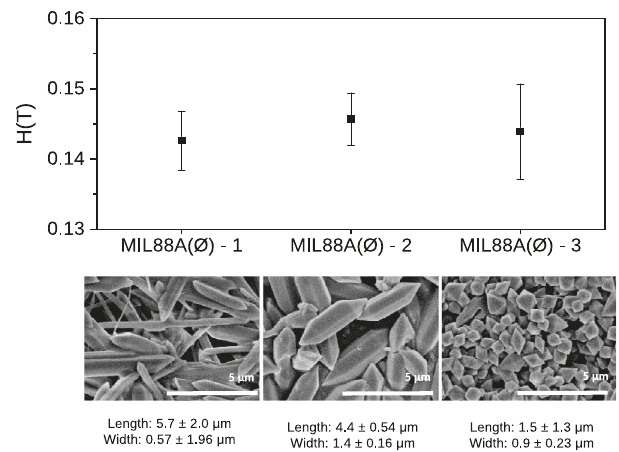
Fig. 4 Critical magnetic fi eld of three different as-synthesized MIL- 88A(Fe) samples. Determination of the critical magnetic fi eld in water for the three as-synthesized MIL-88A(Fe) samples of different sizes. Each sample was measured fi ve times in order to provide the corresponding associated statistical